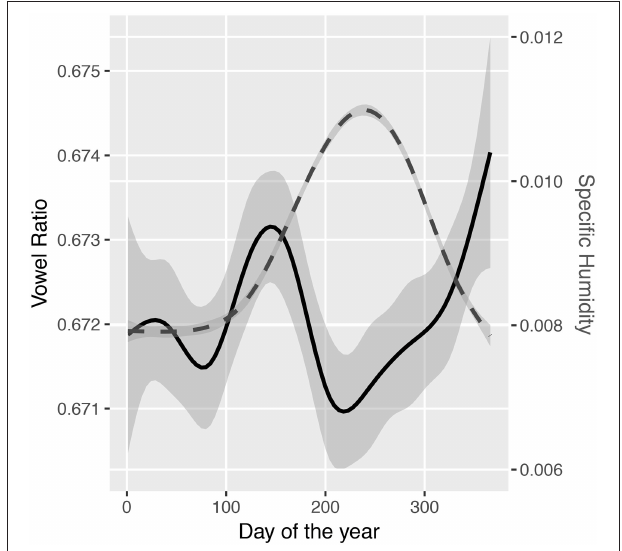
FIGURE 9 | A graph showing the average proportion of vowels used by Larry King (solid line, left axis) and the average specific humidity of Los Angeles (dashed line, right axis) over days of the year. Lines are smoothed using a general additive model with 95% confidence